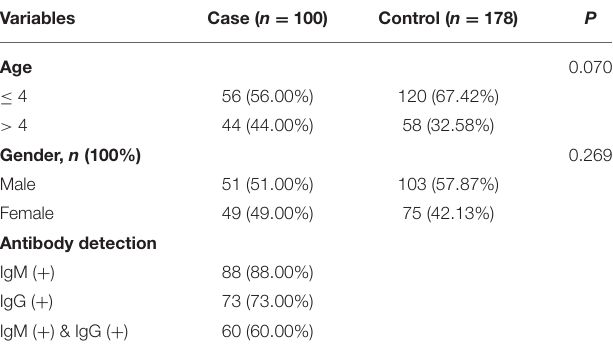
TABLE 1 | Characteristics of the subjects enrolled in this